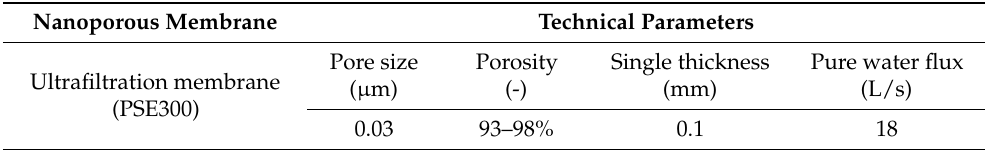
Table 4. Parameters of the nanoporous membrane. Nanoporous Membrane Technical